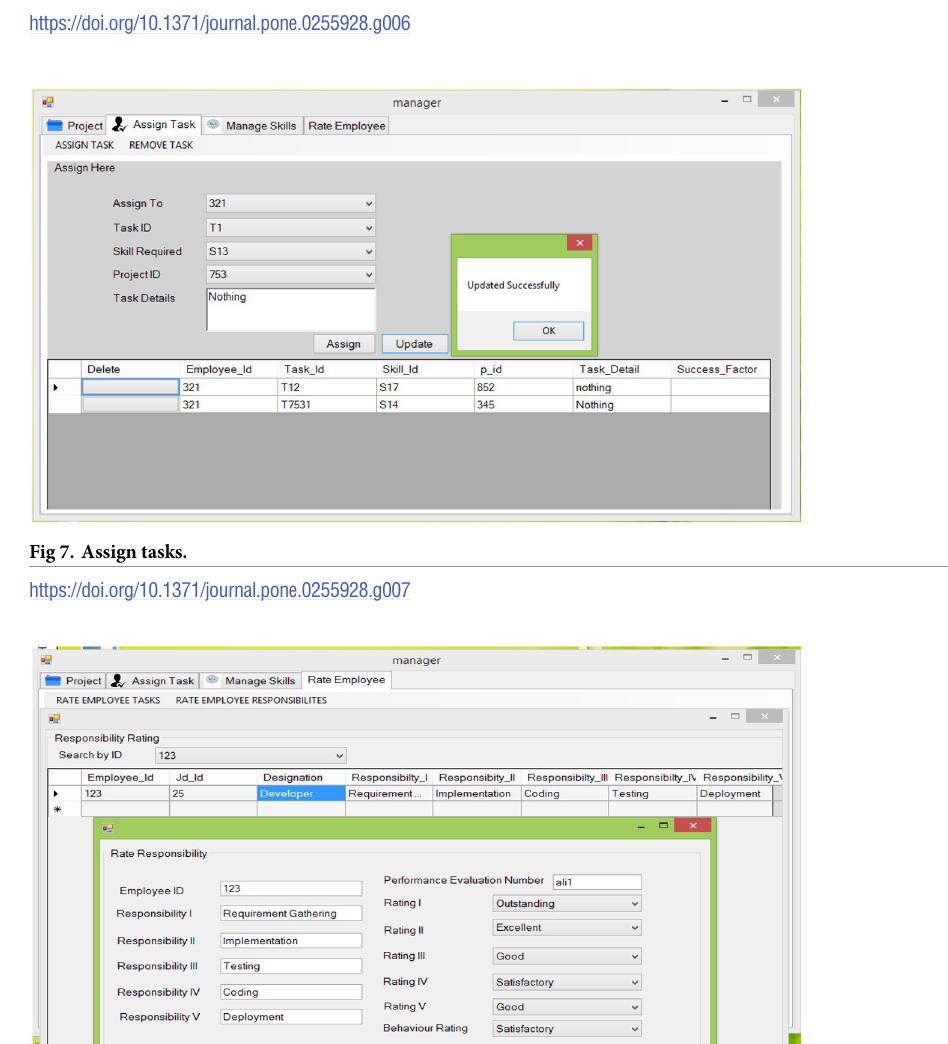
Fig 6. Rate skills.